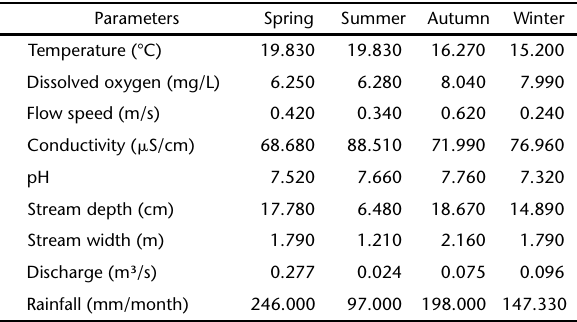
Table I. Enviromental parameters recorded for the Lajeado Bonito stream, Uruguay Basin, Rio Grande do Sul state, Brazil.